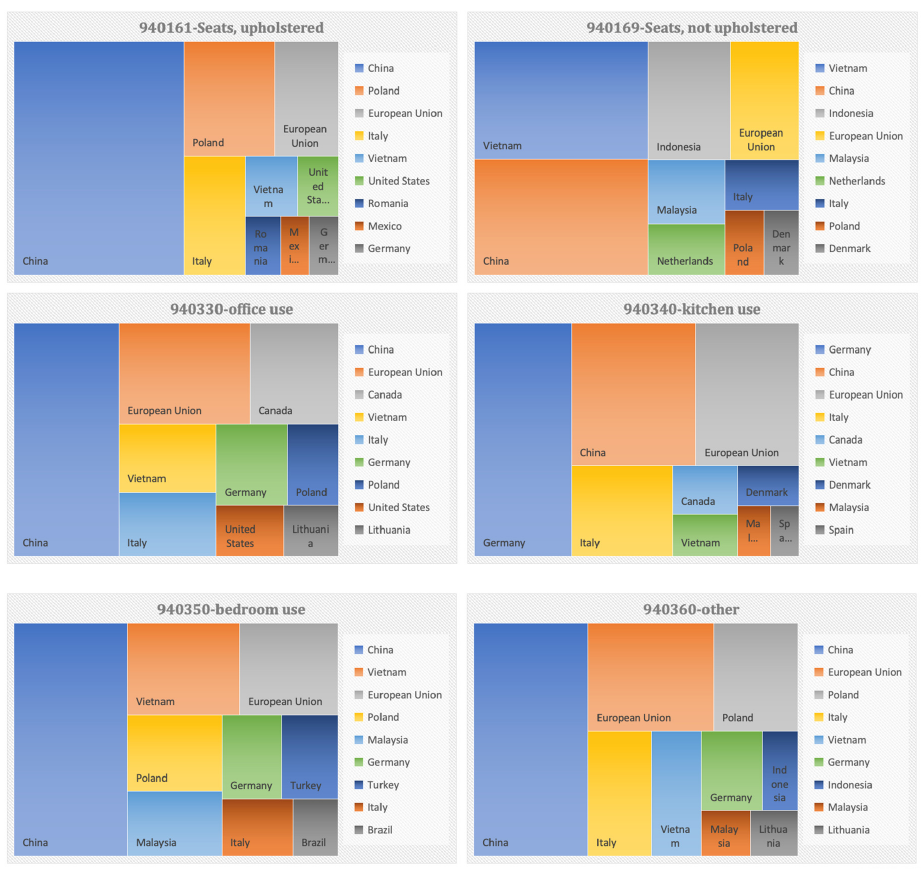
Figure 3. The world’s major exporters of wooden furniture in 2018. Source: calculated according to the data of the United Nations UNCOMTRADE database.